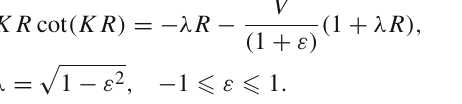
(cid:15) (cid:16) (cid:16) (cid:15) − V V − V ( s ) c V ( s ) , or b